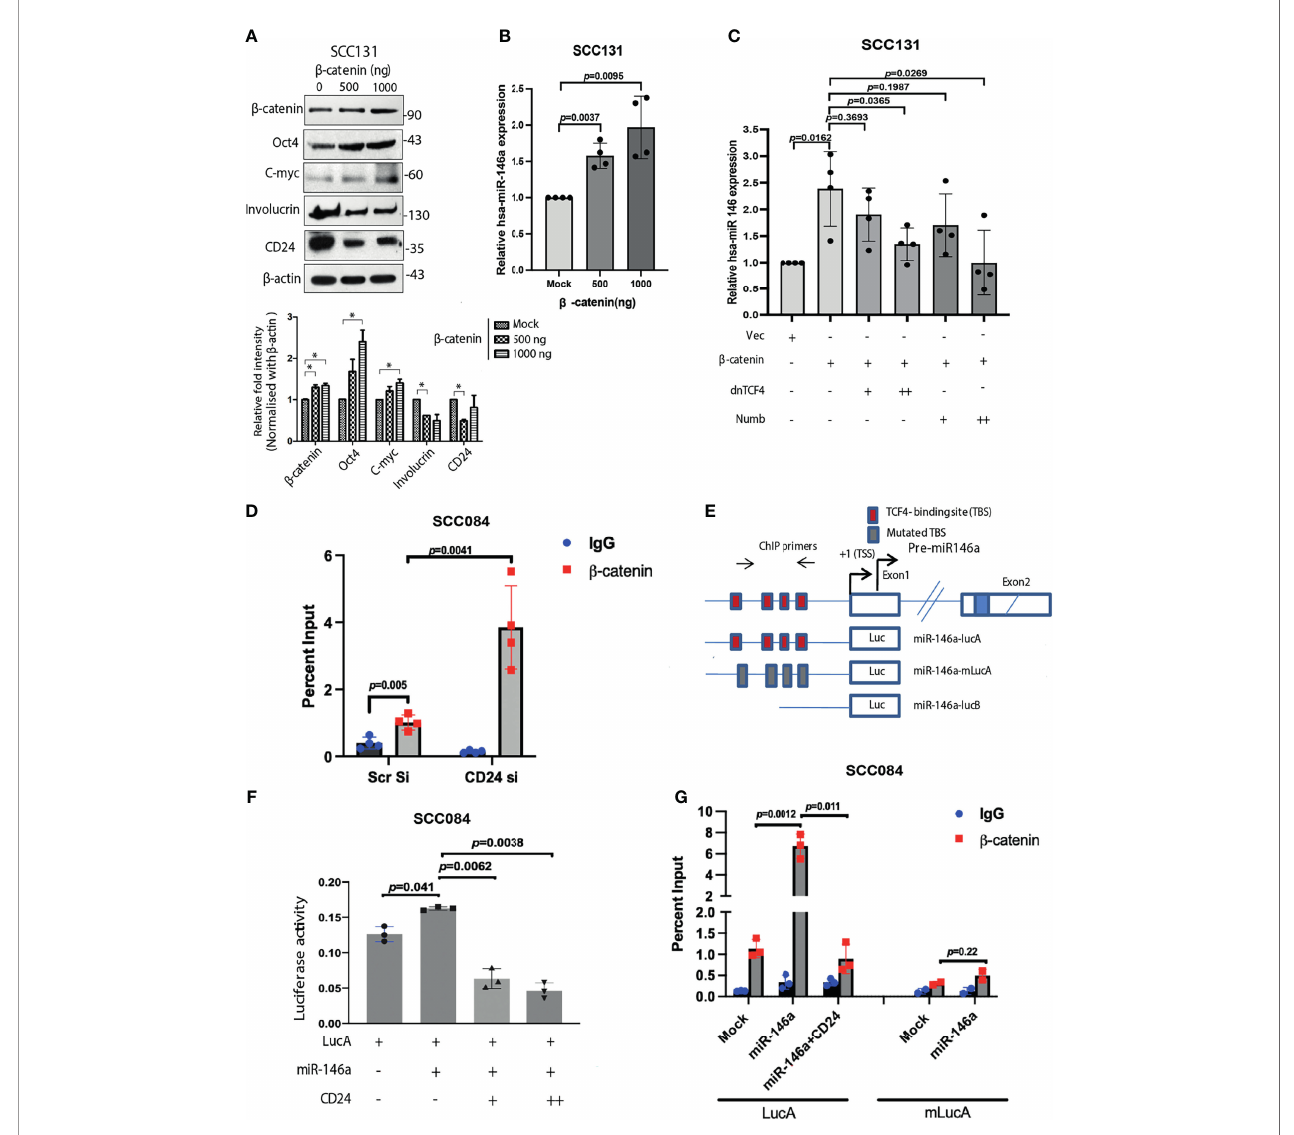
FIGURE 8 | b -catenin transactivates miR-146a mediating a positive feedback loop. (A) Increase in stemness markers upon b -catenin over-expression as revealed by western blot and the densitometric analysis of its band intensities (right below). Data was normalized with corresponding b -actin (*P < 0.05). (B) Concomitant fold change of miR-146a expression in b -catenin transfected SCC131 as quanti fi ed by qPCR. (C) Increase in miR-146a transcripts upon b -catenin over-expression is dose dependently inhibited in the presence of either dnTCF4 or Numb. Unpaired student ’ s t-test were performed on log transformed fold change values in GraphPad prism 8. (D) Chromatin Immunoprecipitation assays in SCC084 cells transfected with either scramble siRNA or CD24 siRNA showing recruitment of b - catenin upon endogenous miR-146a promoter. We used unpaired t-tests on %input to calculate p- values. (E) Schematic of miR-146a promoter locus and reporter constructs namely LucA: wild-type; mLucA: TCF-4 binding site (TBS) mutation; LucB: TBS deletion (20). (F) Relative luciferase activity of LucA in SCC084 cells under various transfections as indicated (one sample t-test was used to compute p-values). Data represent average of n = 3 individual experiments. (G) Transient ChIP assay with same constructs as shown. The percentage enrichment of ampli fi ed product was normalized to input and graphically presented. Data represent mean ± sd and n = 3 different experiments. We used unpaired t-tests calculate p-